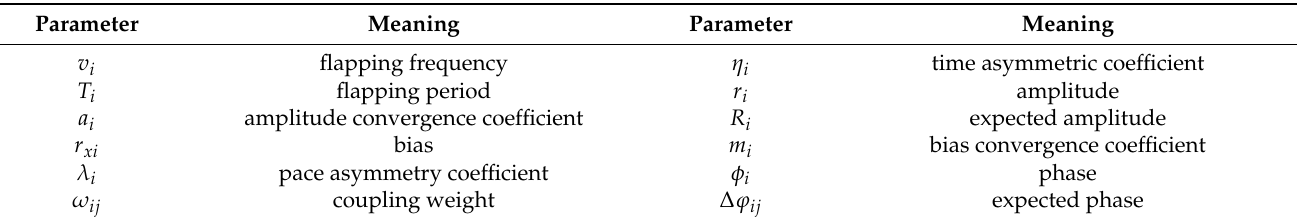
Table 1. Parameters of the phase oscillator model.